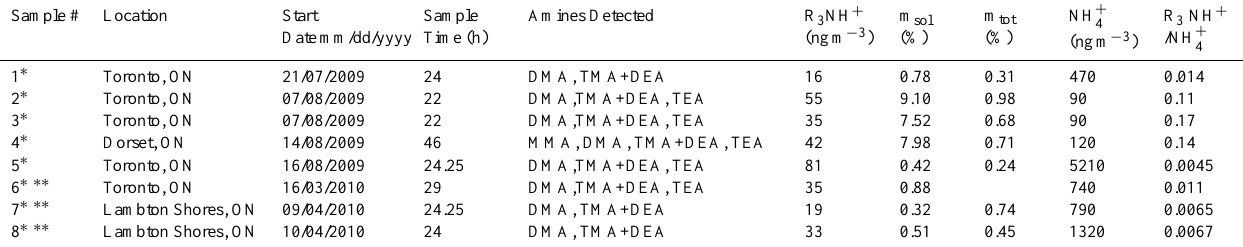
Table 1. MOUDI size-resolved particulate matter sample collection and analysis information. Eight samples were collected over the course of a year using either a rotating or fixed set of MOUDI stages. Mass loadings of PM 1 . 8 amines in the particulate MOUDI samples are reported and then calculated as a function of measureable water soluble mass (m sol ), total mass (m tot ), as well as relative to PM 1 . 8 NH + Sample #